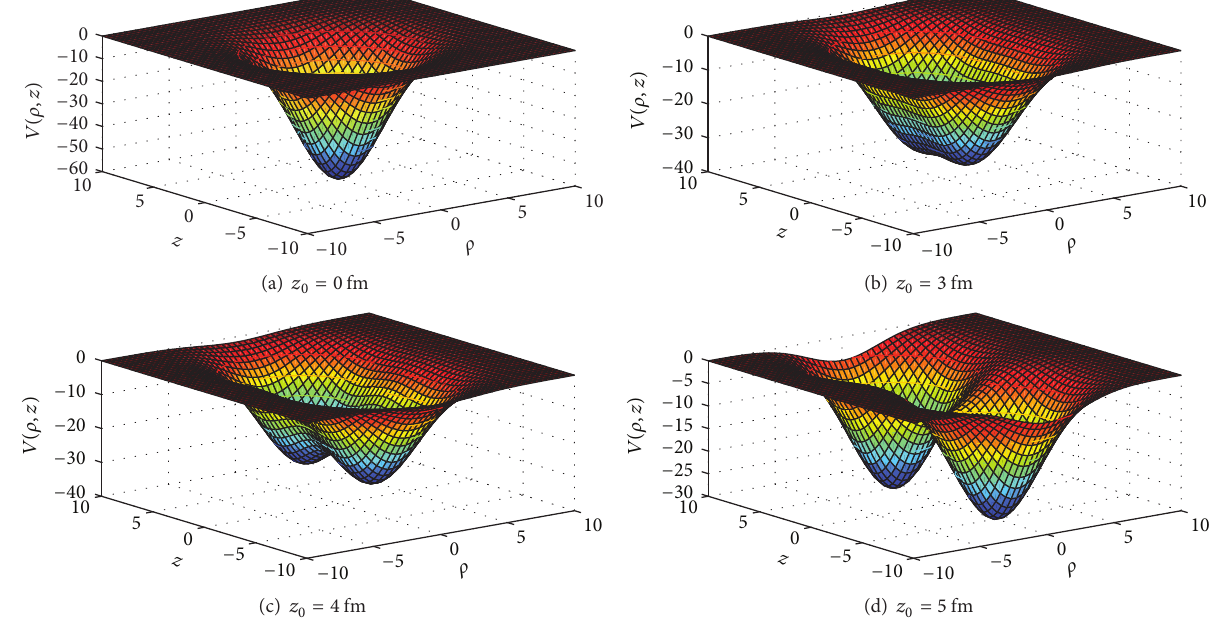
Figure 2: The Gaussian potential for some values of 𝑧 0 .